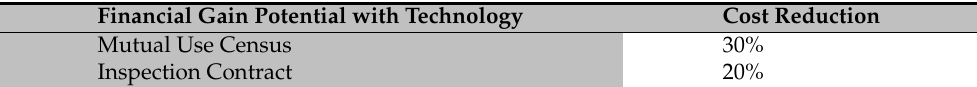
Table 2. General cost reduction for PI and MU